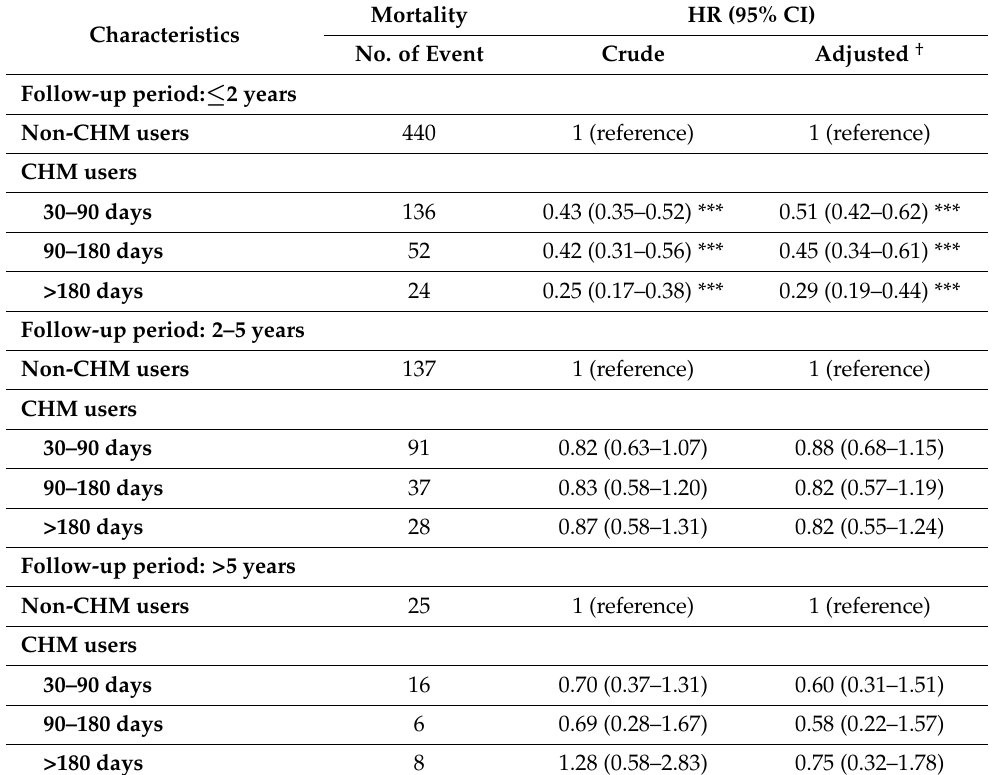
Table 5. The effects of the cumulative days of CHM use on the mortality rate among breast cancer patients stratified by follow-up period.